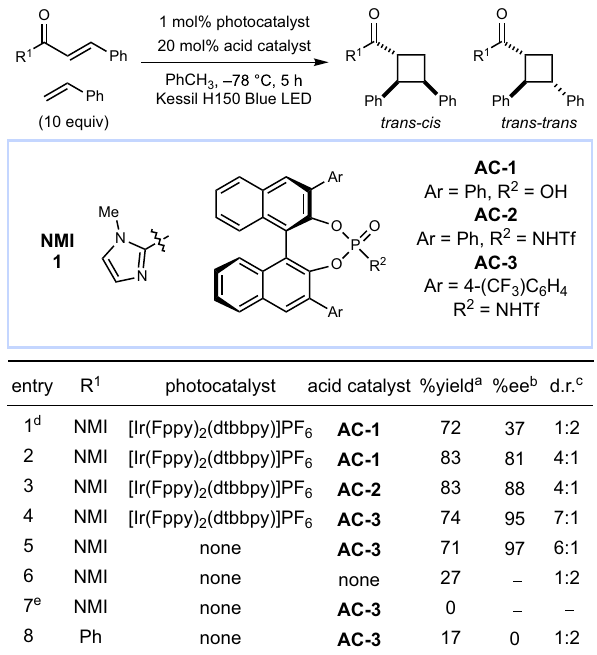
Fig. 2 Optimization studies. a Yields and diastereomer ratios determined by 1 H NMR spectroscopy. b Enantiomeric excess of the major diastereomer determined by chiral HPLC. c Ratio of trans – cis isomer to trans – trans isomer. d Conducted at room temperature. e Conducted in the